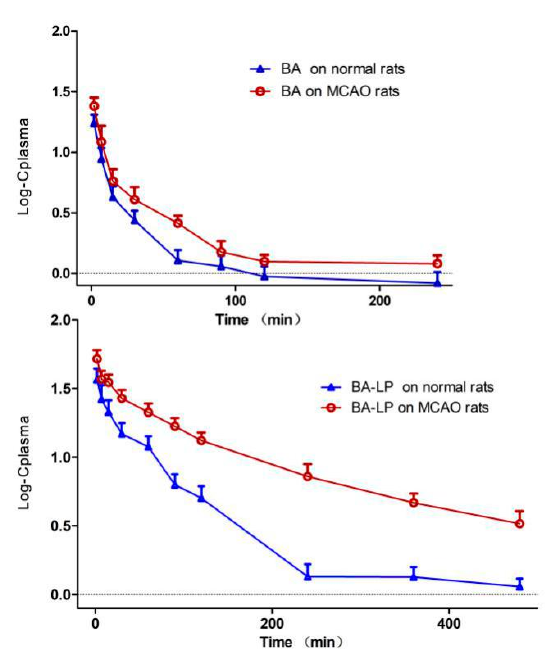
Figure 4. The Log plasma concentration-time profiles (mean (SD)) of BA and BA-LP on normal and MCAO animal models ( n = 5). Table 3. Pharmacokinetic parameters of BA and BA-LP on normal and MCAO animal models ( n = 5). Values are mean (SD).